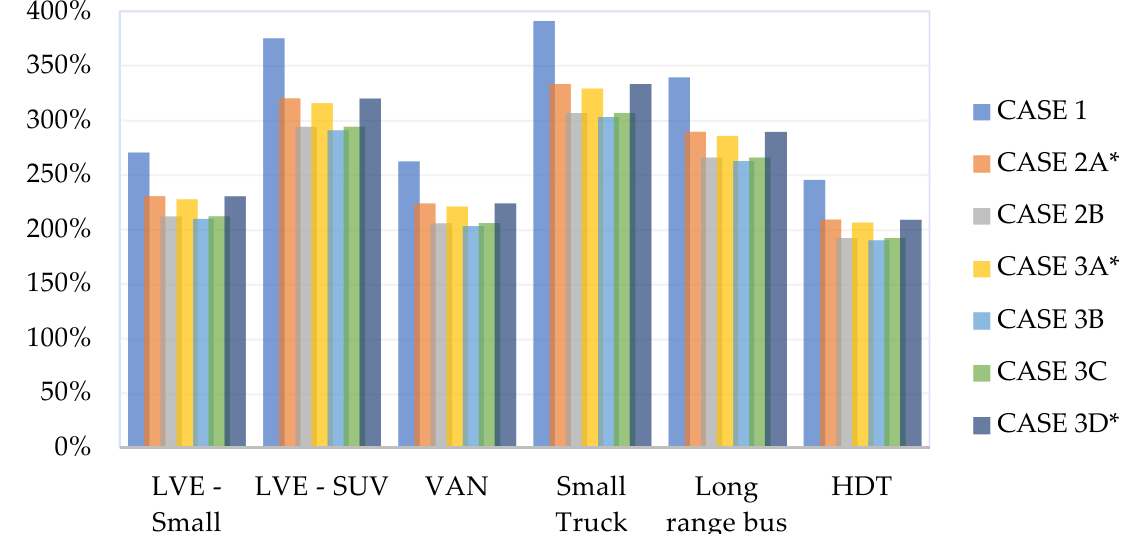
Figure 11. CF of the product during its utilization versus the product’s production CF.